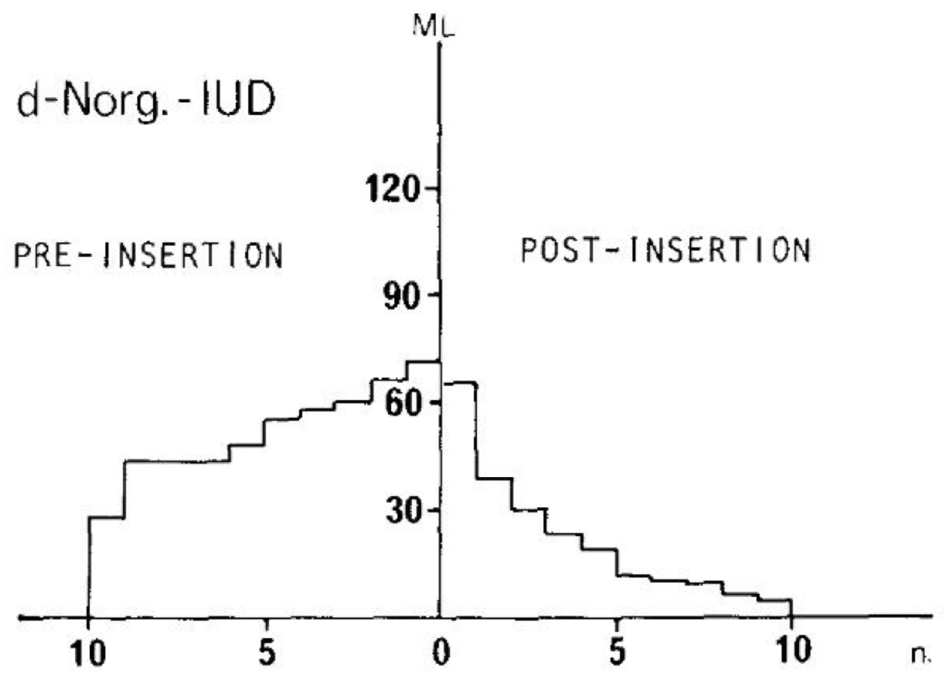
Figure 3. Duration and intensity of menstrual blood loss before and during 3 cycles after insertion of an experimental levonorgestrel ‐ releasing device. From: Nilsson (1977) [42] (reproduced with per ‐ mission).